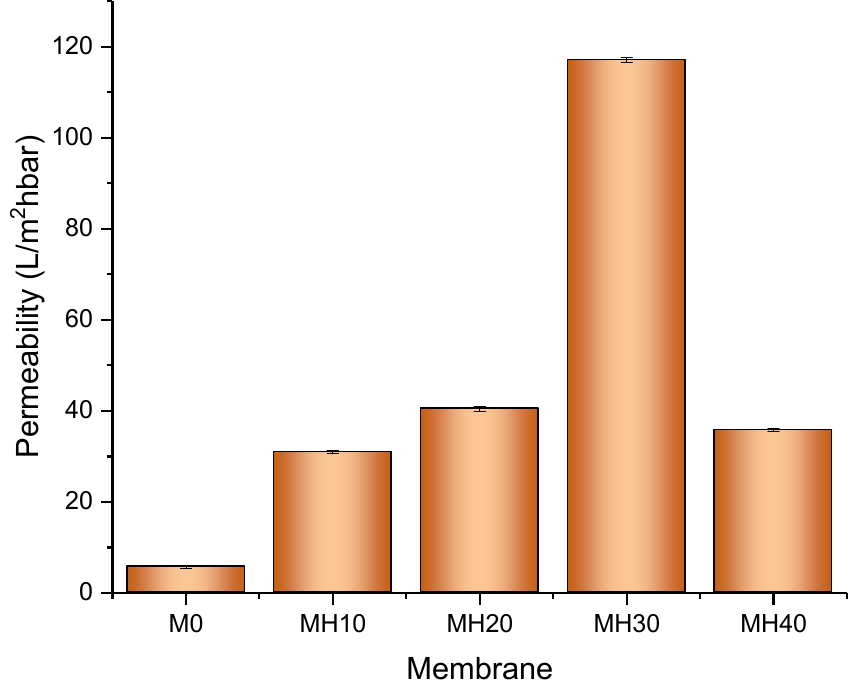
Figure 10. Water flux and permeability of the PSf/HAP DLHF membrane across the membrane (out-to-in cross flow) ( n = 3 ).